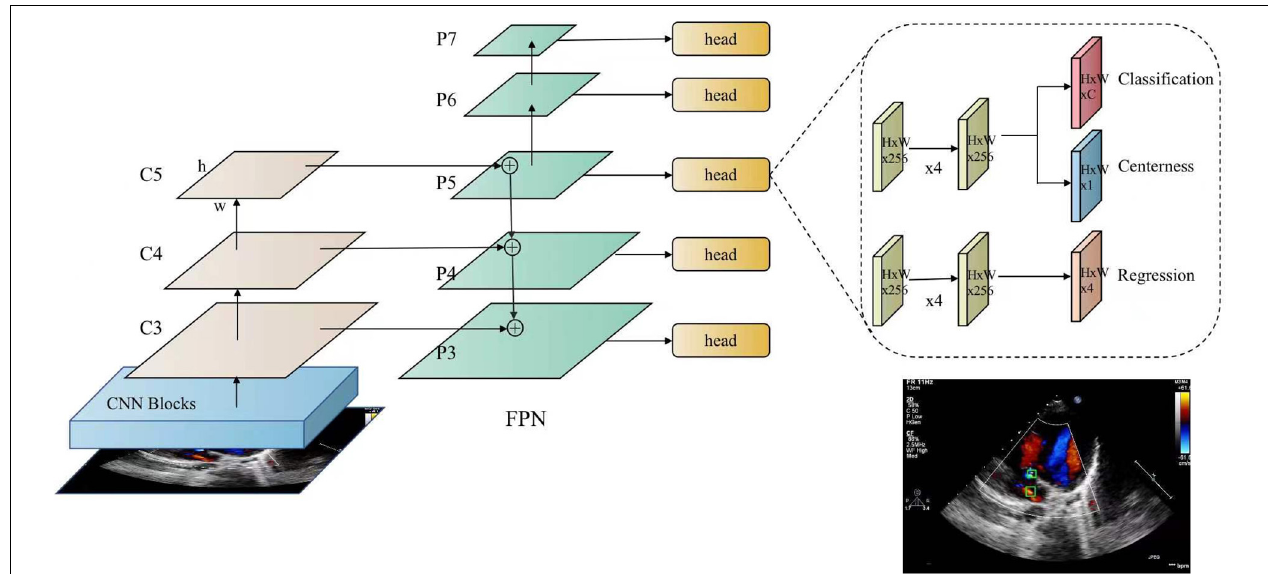
FIGURE 4 | FCOS detector for atrial septal defects. FCOS consists of three parts, including the backbone (CNN), neck (FPN), task-special heads (classification, centerness, and